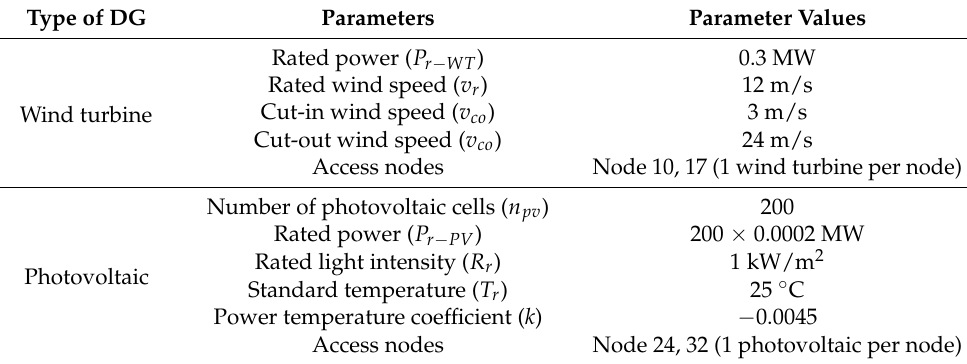
Table A1. Parameters of distribution generations.